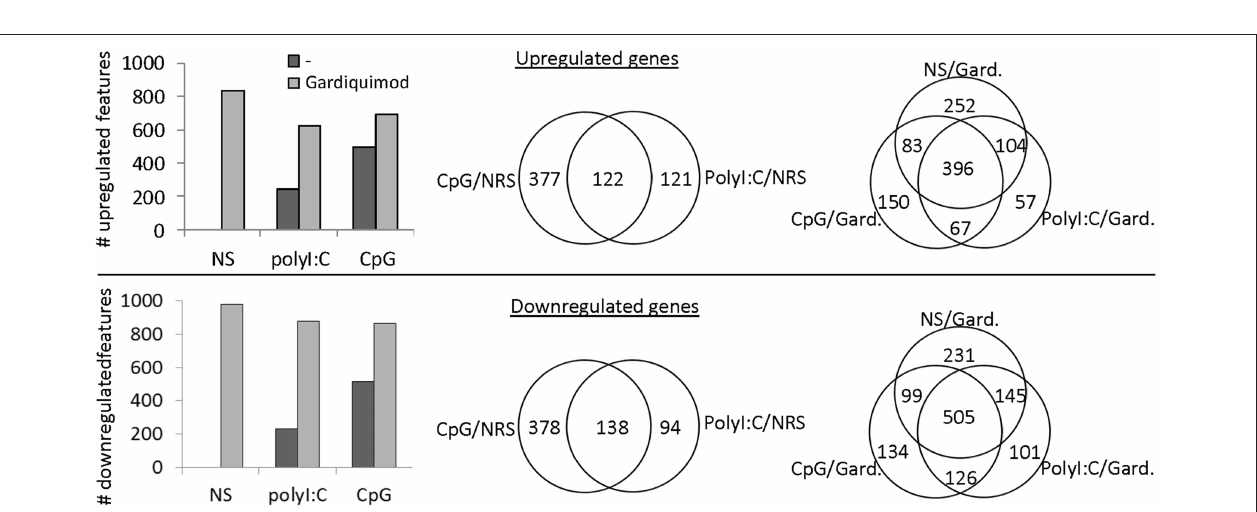
FIGURE 5 | Microarray analysis—transcriptional response of salmon MPs to long term stimulation with polyI:C and CpGs and restimulation with gardiquimod. MPs were left non-stimulated (NS) or stimulated with 2 µ M CpGs or 20 µ g/ml of polyI:C. After 6 days, samples were restimulated with 1 µ g/ml of Gardiquimod and RNA from both non-restimulated (NRS) and restimulated samples was sampled on day 7. Pooled RNA samples of cells from two individuals were analyzed using a salmonid oligonucleotide microarray. Features with fold change values of + 2 and − 2 as compared to the NS samples were considered up- and downregulated, respectively. The histograms show the total numbers of up- and downregulated features in the different samples. The Venn diagrams show the numbers of common and unique up- and downregulated genes among the